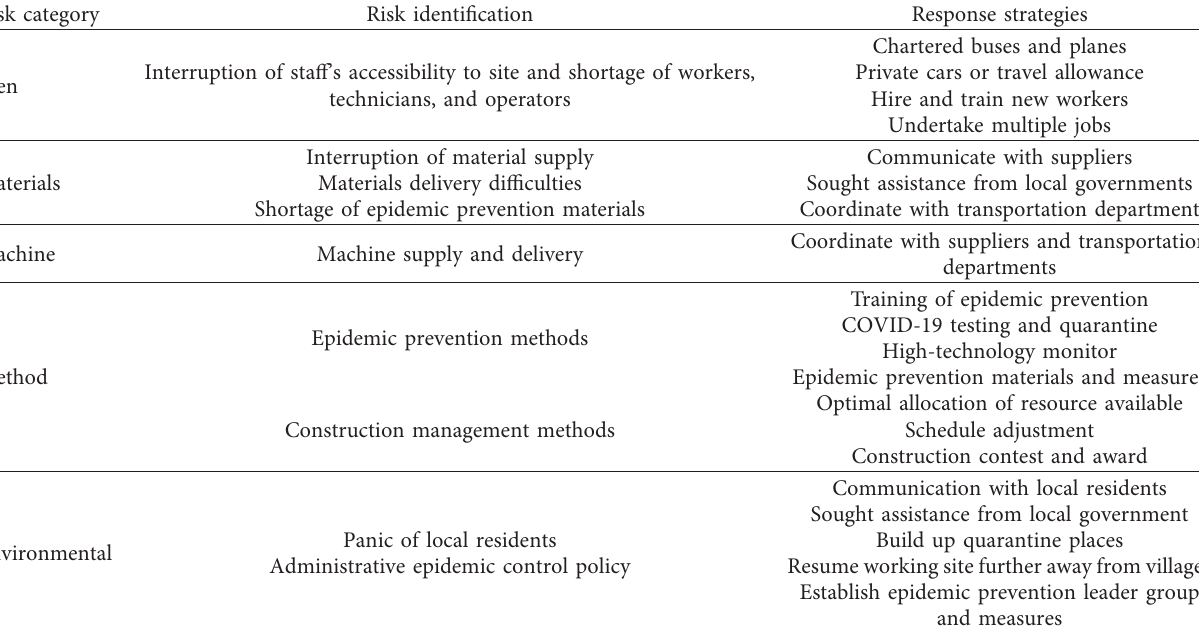
Table 2: Summary of COVID-19 risks in tunnel construction